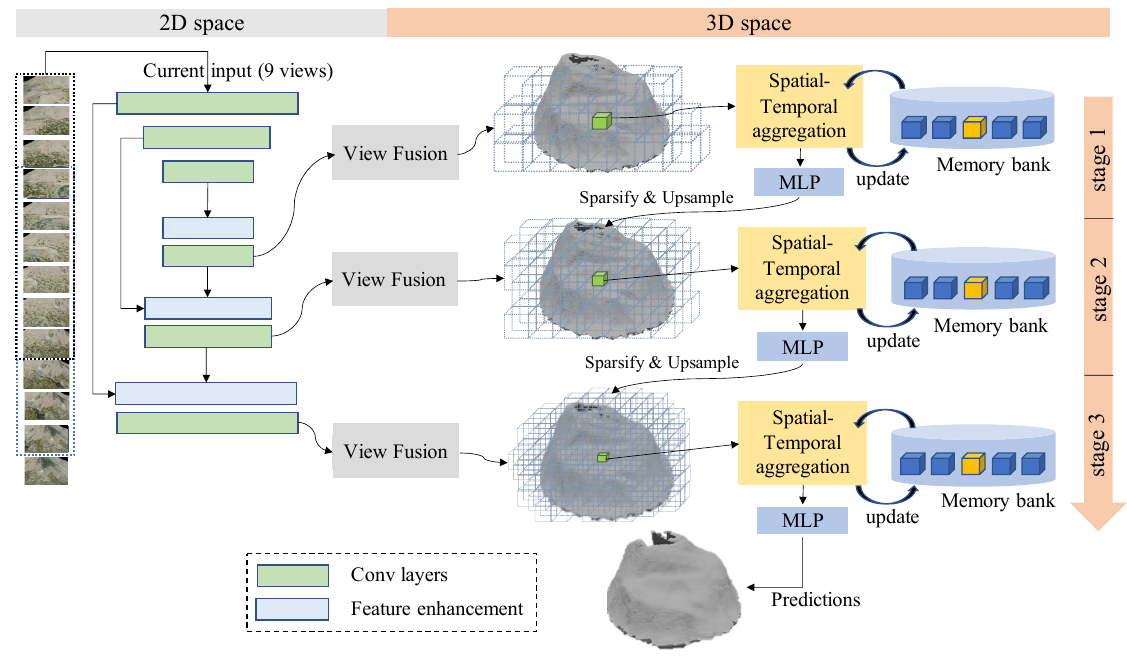
Figure 2. We adopt a coarse-to-fine pipeline to generate the reconstruction result. First, an encoder– decoder network extracts 2D features where the view fusion via reweighted mechanisms is proposed to generate more discriminative features. Then the view fusion module maps each level 2D feature to 3D volume through camera parameters. Furthermore, the spatial–temporal aggregation module eliminates the reconstruction ambiguity in timing. Finally, we update the memory bank with fused features and predict the TSDF value of each